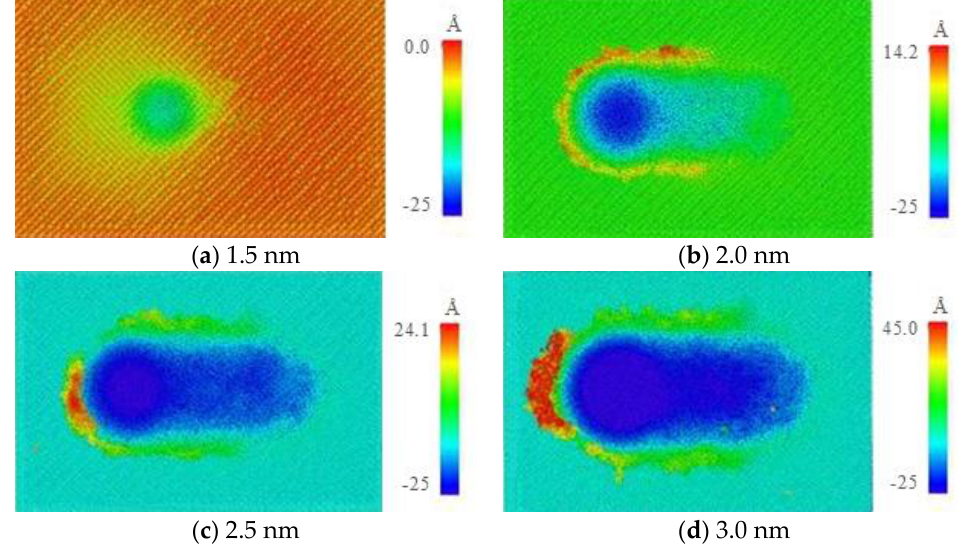
Figure 5. Scratch morphology with different indentation depths.